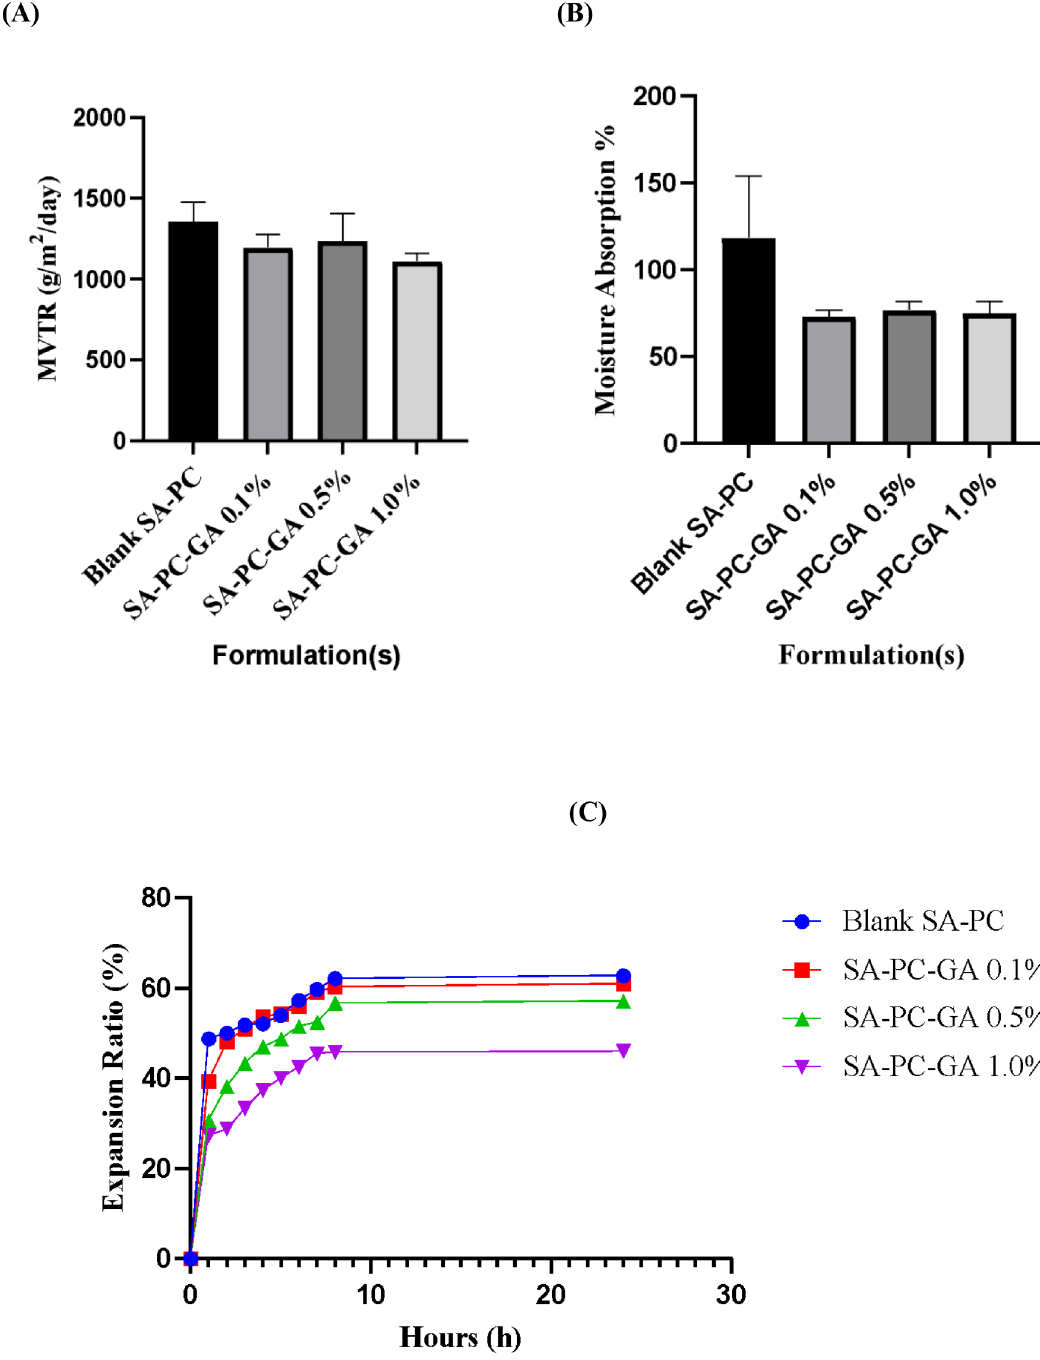
Figure 3. (A) Moisture vapor transmission rate (MVTR), (B) Moisture absorption % and (C) Expansion ratio ( % ) of film formulations incorporated with gallic acid (mean (cid:1) SD, n = and expansion rate in the first 4 h. The film expansion ratio was presumed to be related to the viscosity profile of the formulated films, as reported by Thu et al . (2012). Since SA-PC-GA 0.1% w/v hydrocolloid film is having the least viscosity, it swells upon moisture uptake more rapidly and loses its circular shape quicker. The film expansion ratio was observed to be slower in SA-PC-GA 0.5% w/v and followed by SA-PC-GA 1.0% w/v hydrocolloid film, which is having the lowest expansion ratio. All the hydrocolloid films attained a nearly plateau state after 8 h, where they became highly